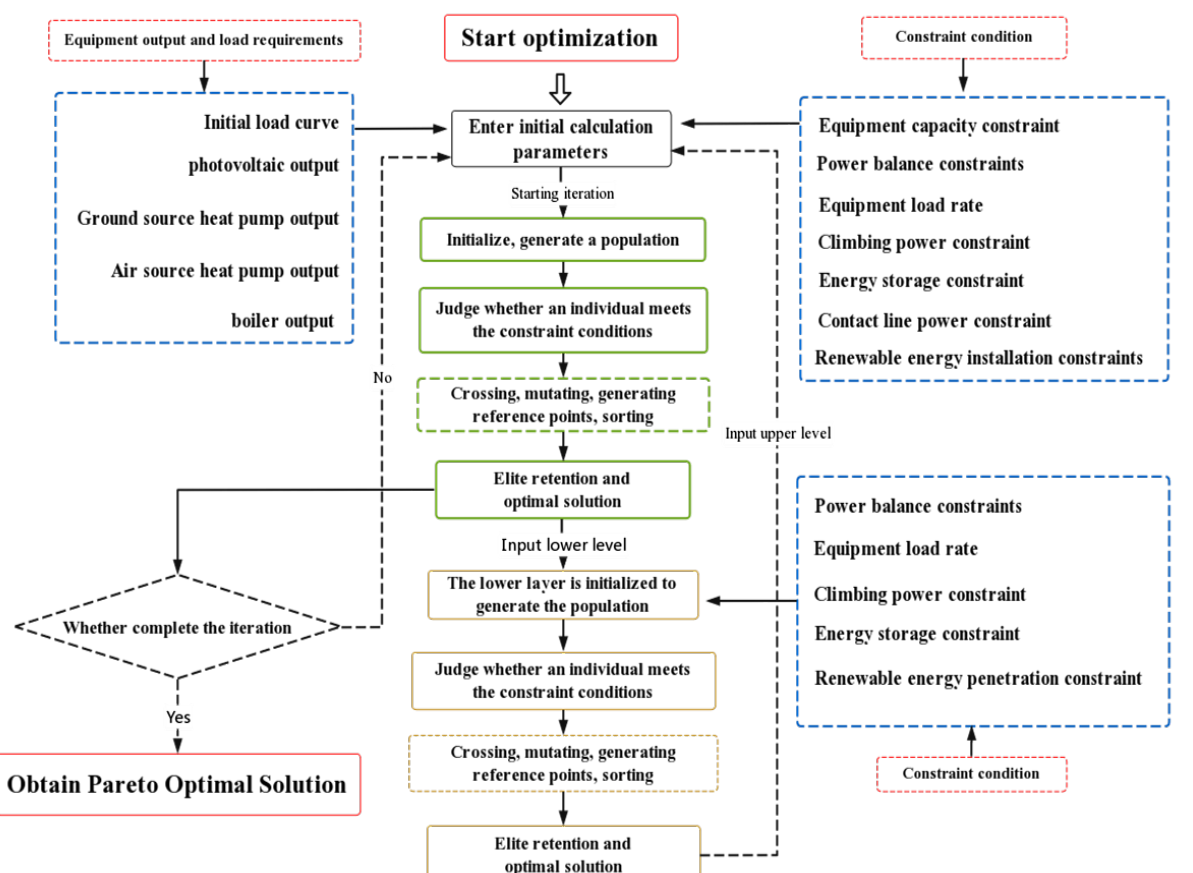
Figure 2. Calculation process of the bi-level multi-objective collaborative optimization